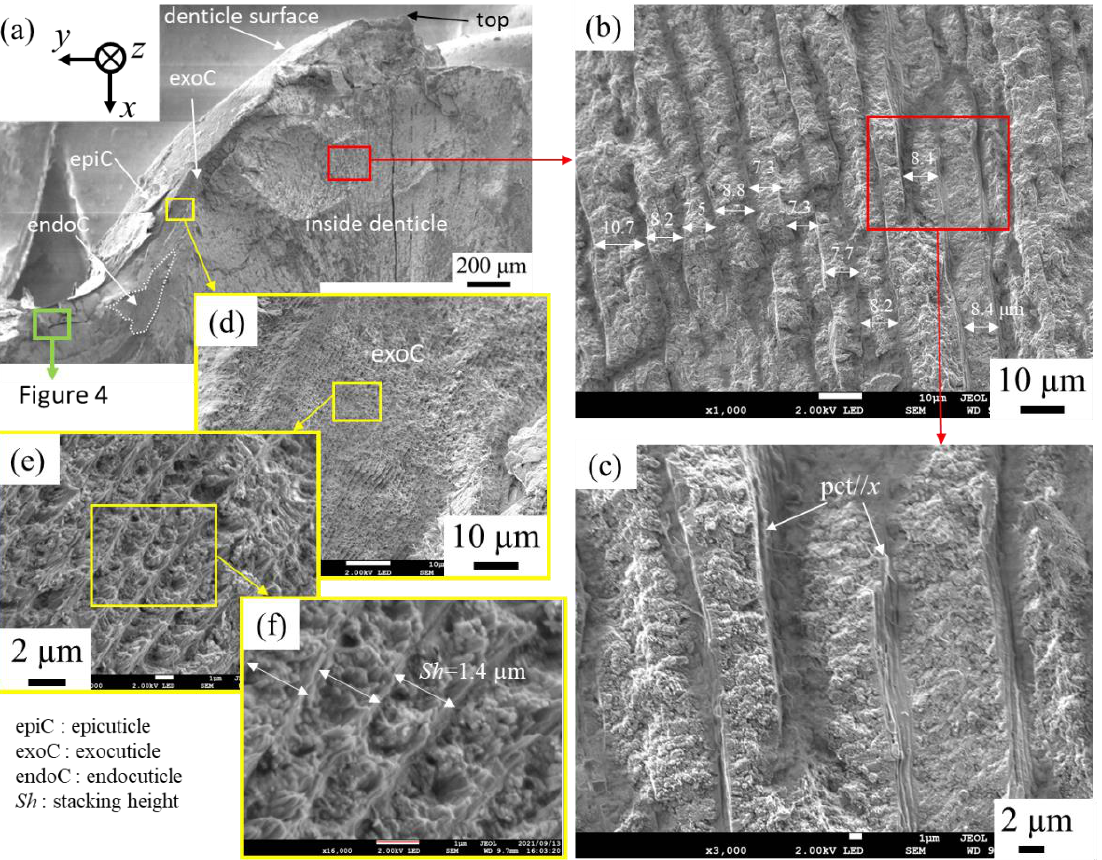
Figure 3. SEM micrograph of ( a ) a fracture surface of the denticle. Enlarged SEM micrographs of the area enclosed by rectangles in ( a ); ( b , c ) inside the denticle and ( d – f ) the exocuticle layer. Here, pct denotes pore canal tubules.